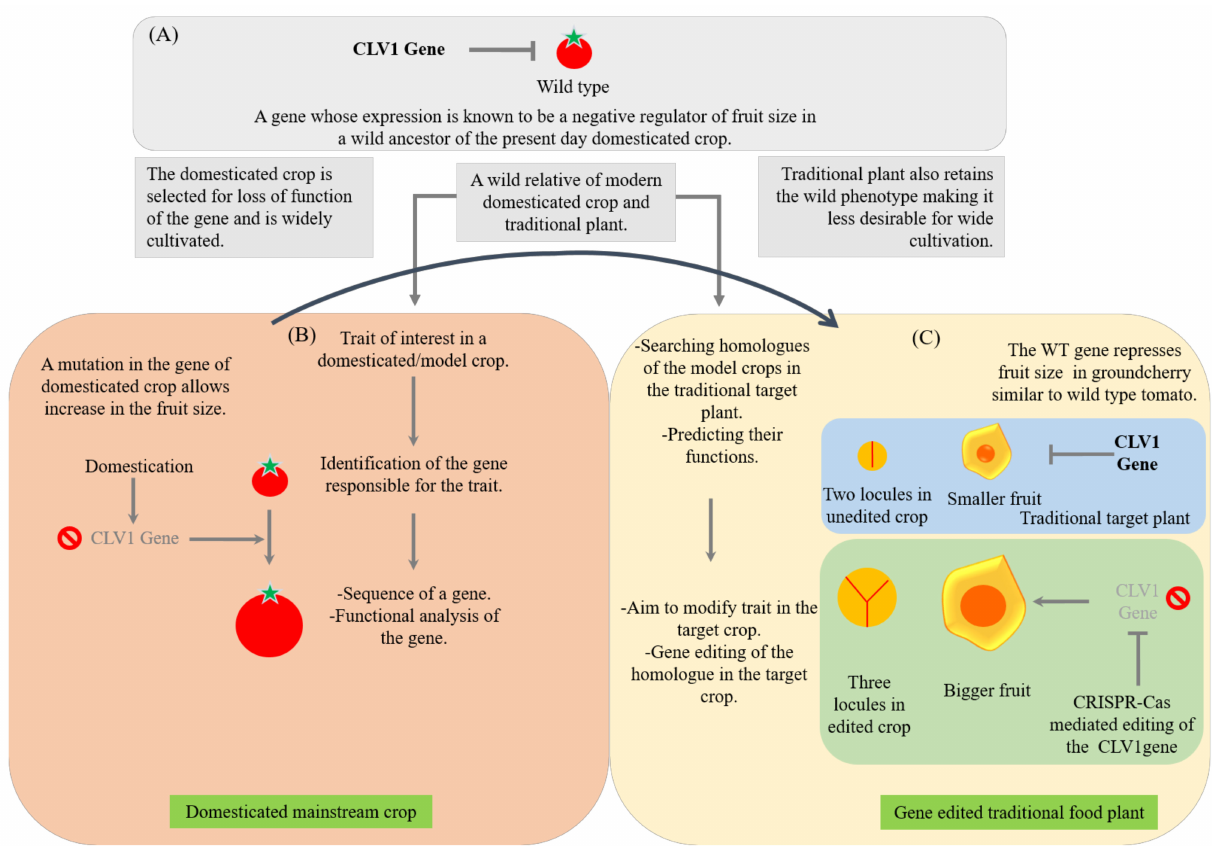
Figure 4. Example of rapid improvement of a traditional orphan food crop for larger fruits. The genomics information obtained from the tomato (a domesticated crop) genome sequencing and the functional analysis of the genes is directly translated to the traditional crop, groundcherry (a traditional food plant) [446]. A wild type gene CLV1 which is a negative regulator of fruit size in the domesticated tomato ( A ), a mutation during domestication has occurred in this gene leading to the formation of a bigger fruit size of domesticated tomato ( B ) and its homologue in a traditional food plant, groundcherry is targeted for gene editing for its improvement for bigger fruits ( C